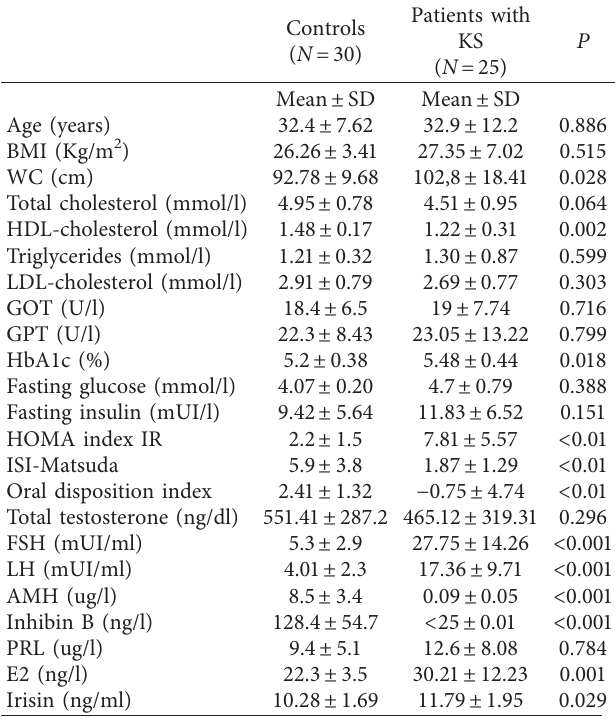
Table 1: Comparison of anthropometric, metabolic, and hormonal parameters between patients with Klinefelter’s syndrome and healthy controls.